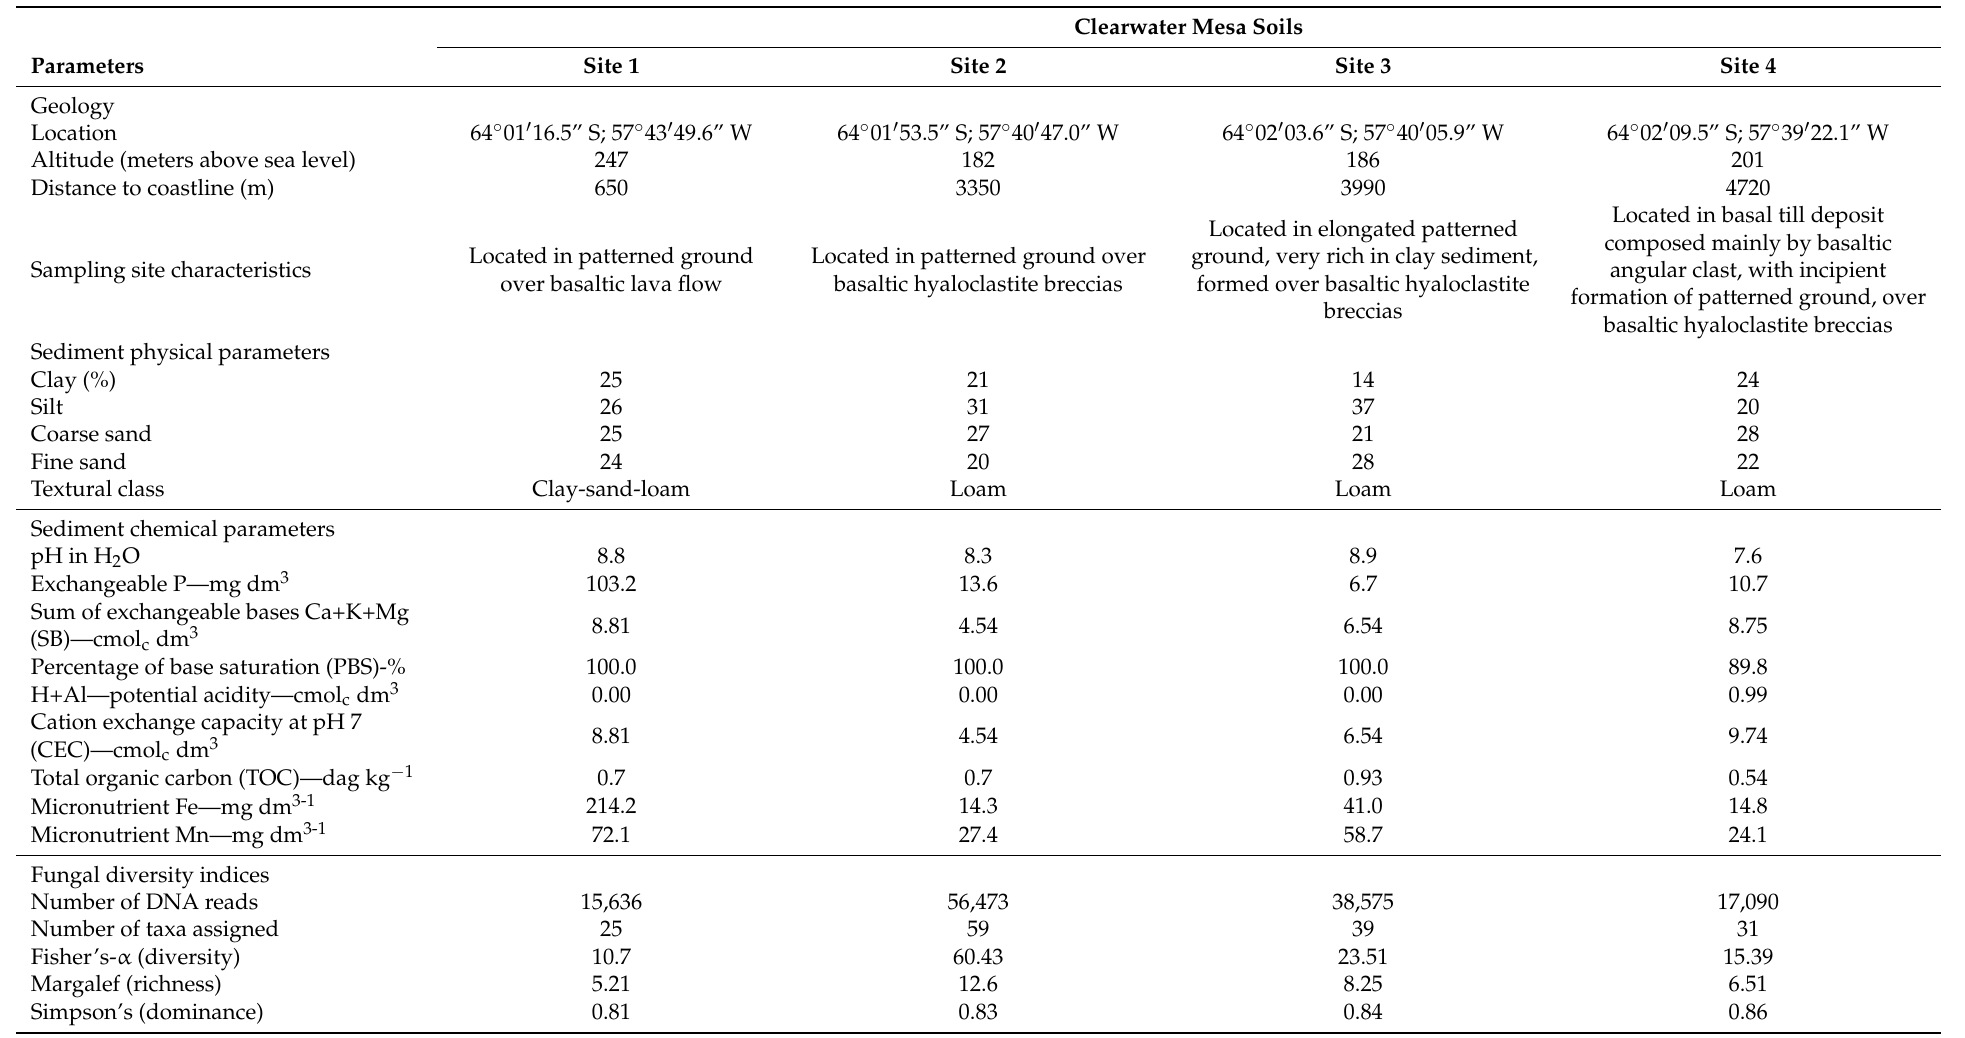
Table 1. Locations, characteristics, soils physicochemical data and diversity indices of the fungal assemblages present in soil samples obtained at Clearwater Mesa, James Ross Island, north-east Antarctic